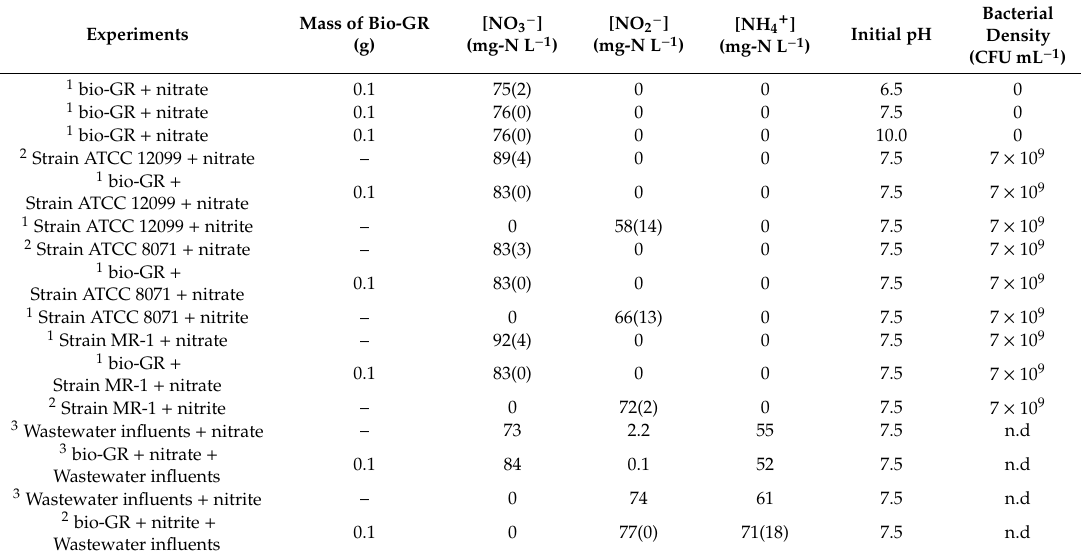
Table 2. Initial conditions of biotic and abiotic experiments. All experiments performed with strains ATCC 12099, ATCC 8071, and MR-1 were carried out with 48.5 mM of methanoate as the sole electron donor and at room temperature under anoxic